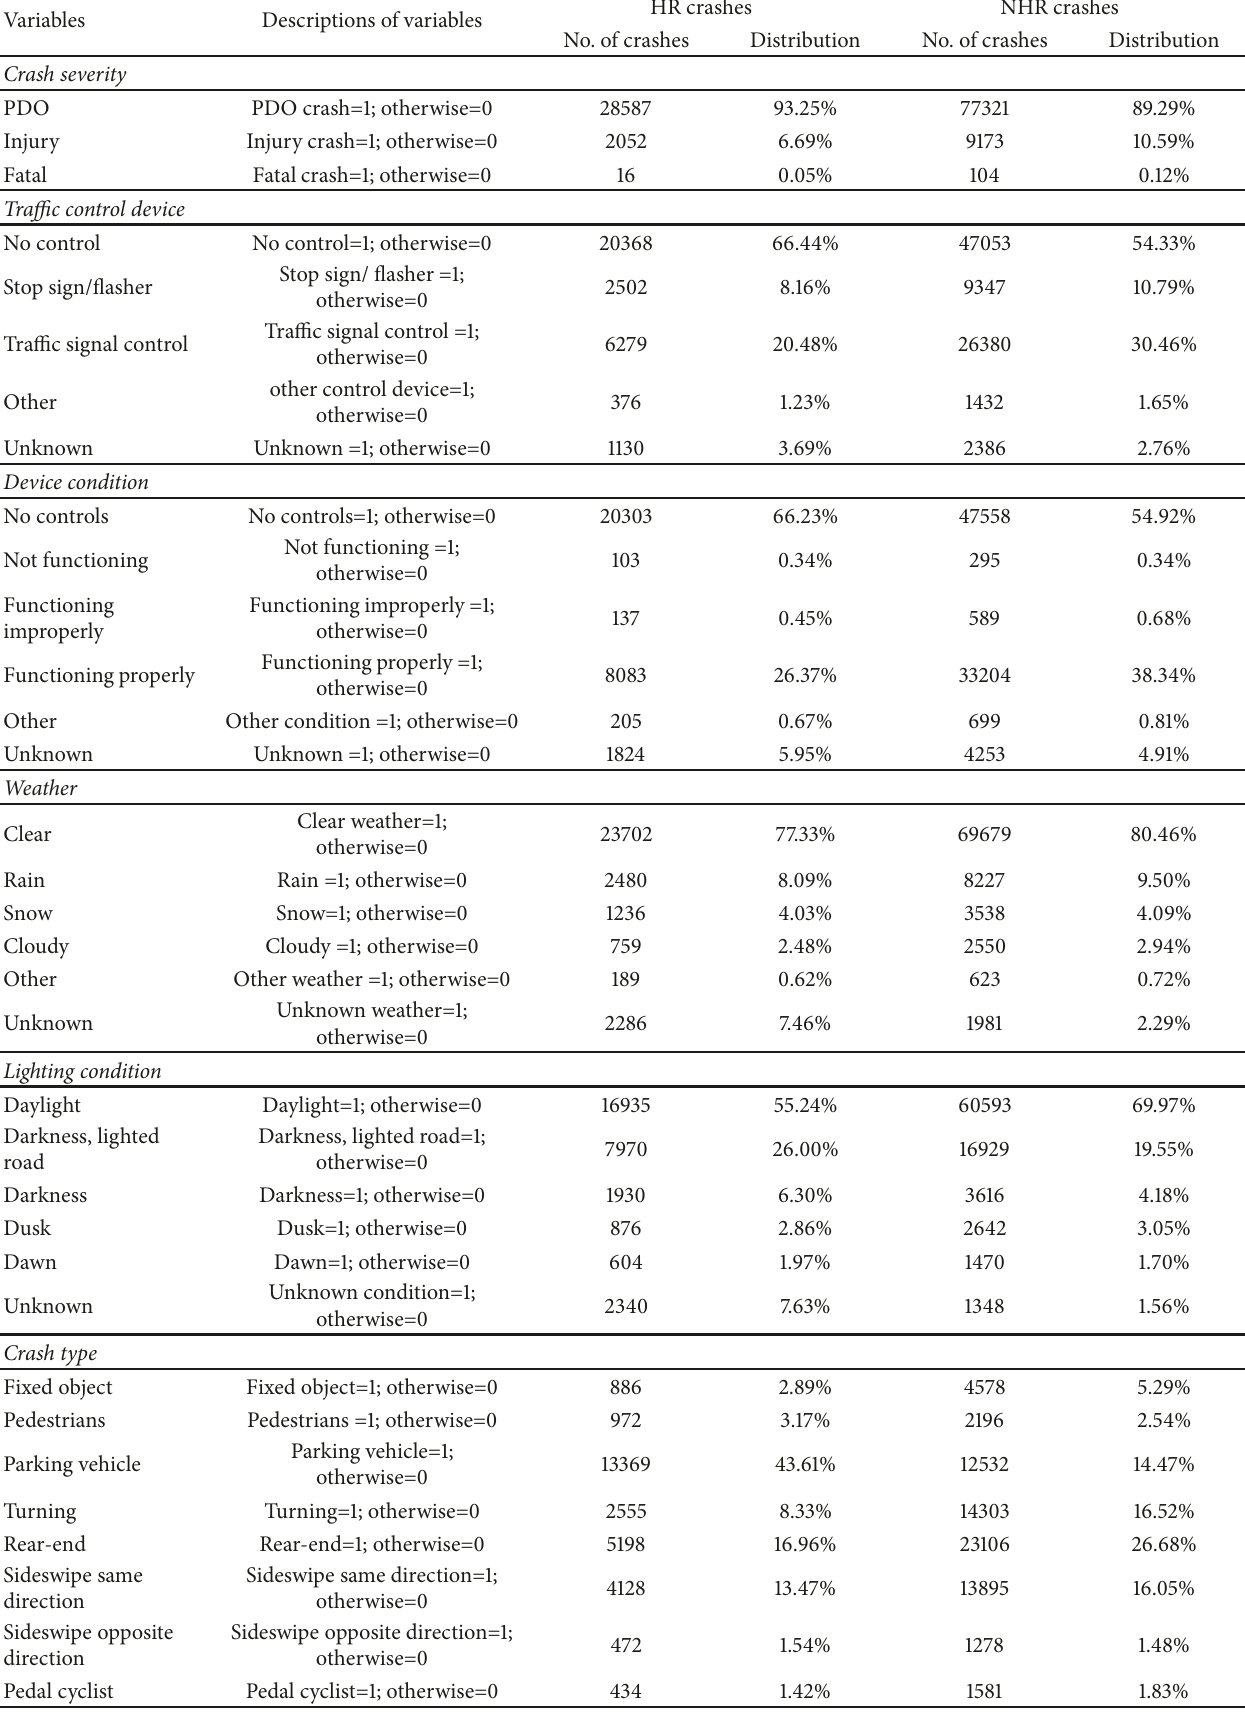
Table 1: Variables description and percentage distribution for HR and NHR